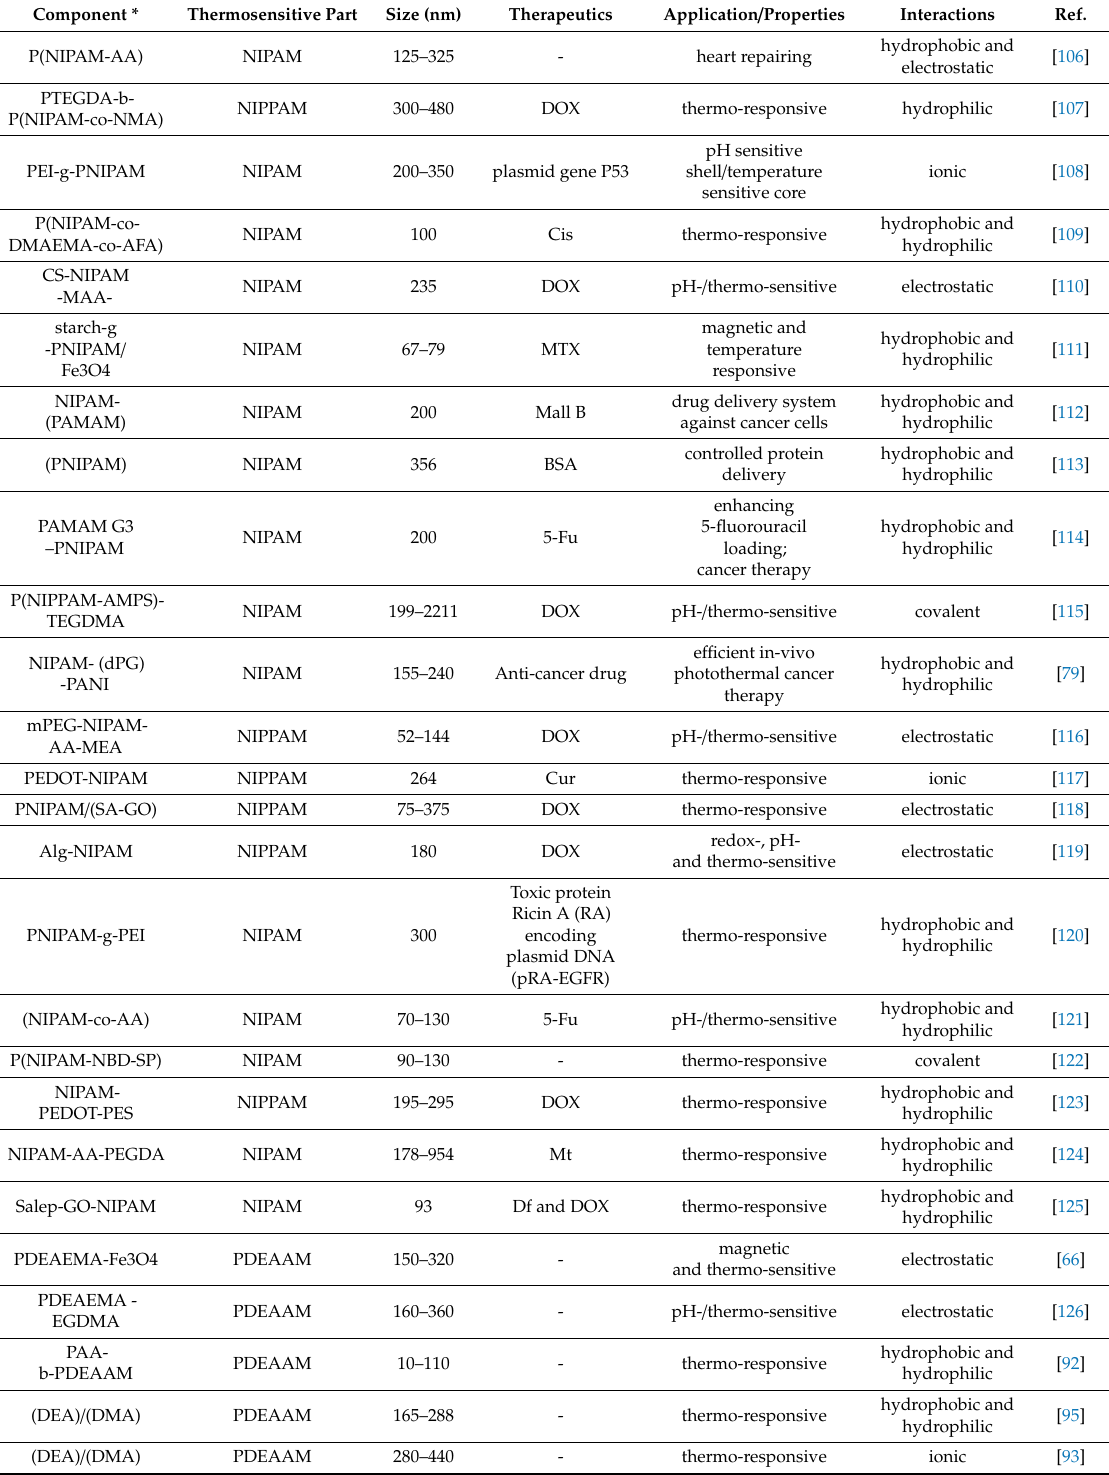
Table 1. Components and applications of investigated thermosensitive nanogels containing polymers bearing amide groups. “-“ means there is no therapeutic agent introduced in the reference paper and only thermosensitive drug carrier was synthesized and